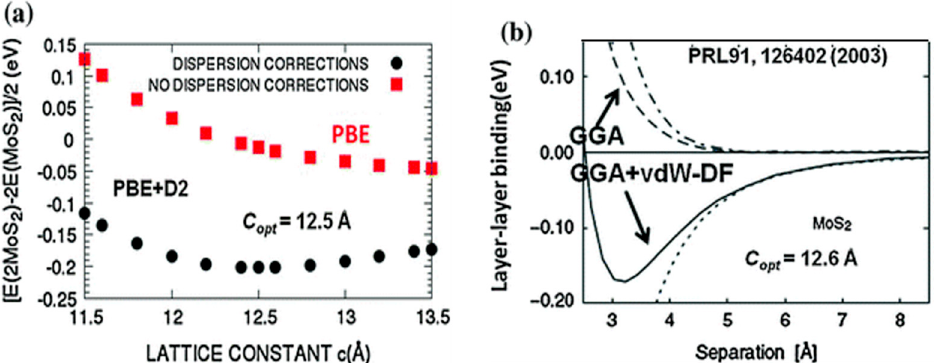
Figure 3. Noncovalent interactions in bulk MoS 2 . ( a ) The binding energy of bulk MoS 2 with respect to the decomposition into two MoS 2 layers with (black solid circles) and without (red squares) Grimme’s D2 dispersion corrections. ( b ) Interlayer binding energy as a function of the separation of two MoS 2 layers (black solid line) using a vDW-DF approach. Reproduced with permission from [20]. Springer International Publishing Switzerland,